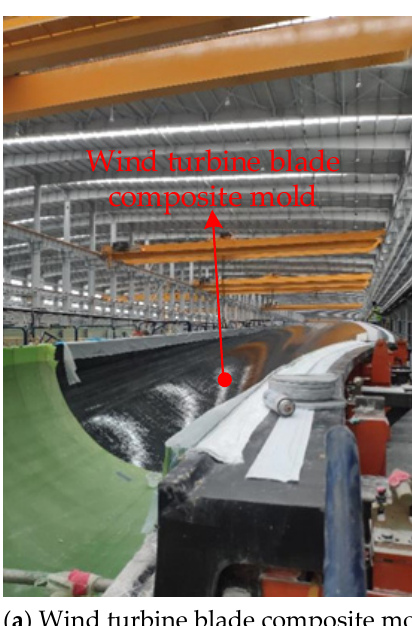
Figure 10. Large-space laser projection experiment site.